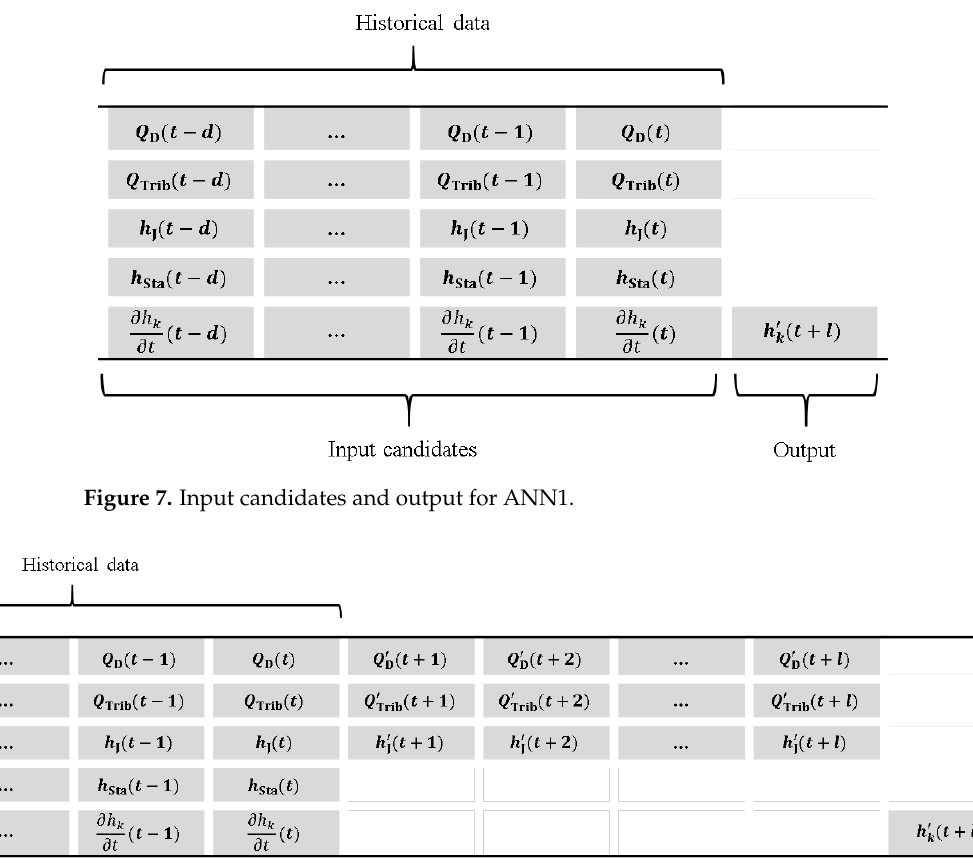
12 of 22 Figure 6. Identified power functions for upstream reach and downstream reach. 4.2. Error Correction Using ANN Models 4.2.1. PMI-Based Input Variable Selection In order to test the approach that combines the hydrodynamic model and ANNs, a performance comparison of the hydrodynamic model, ANNs, and hybrid model (hydrodynamic model with ANN-based error correction model) was carried out. An ANN model, labeled here as ANN1, was developed to forecast water levels at specific